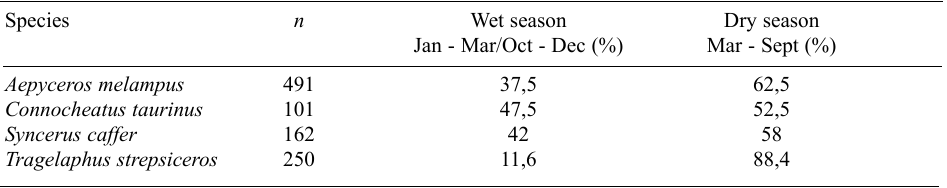
The seasonal distribution of natural mortalities on Letaba Ranch, Limpopo Province